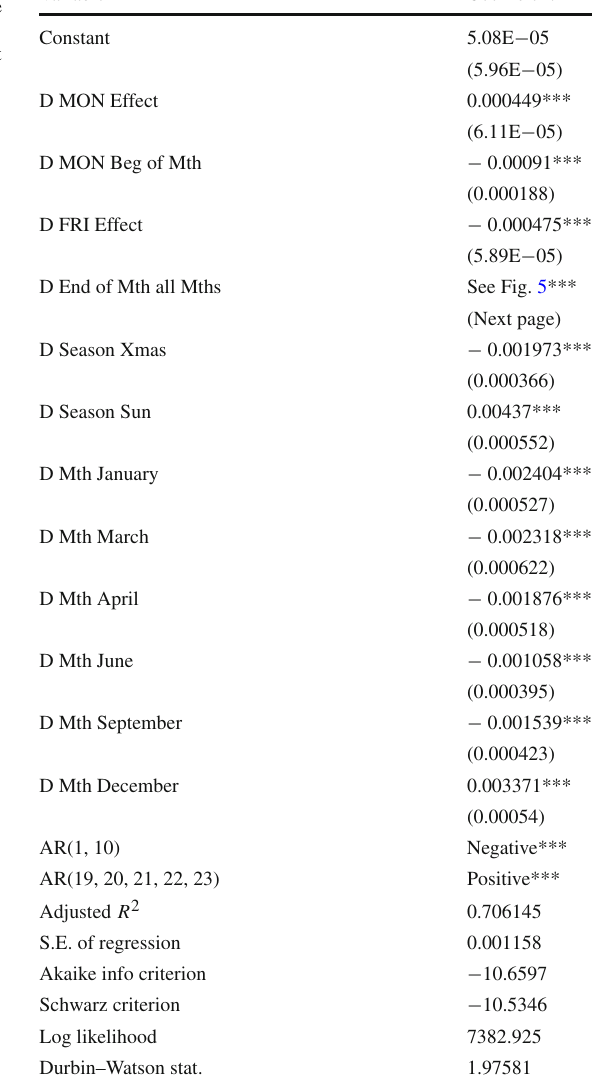
Table 2 The univariate time series model for the growth rate of affiliations. We include differenced dummies consistent with the model for the flows: D DAY